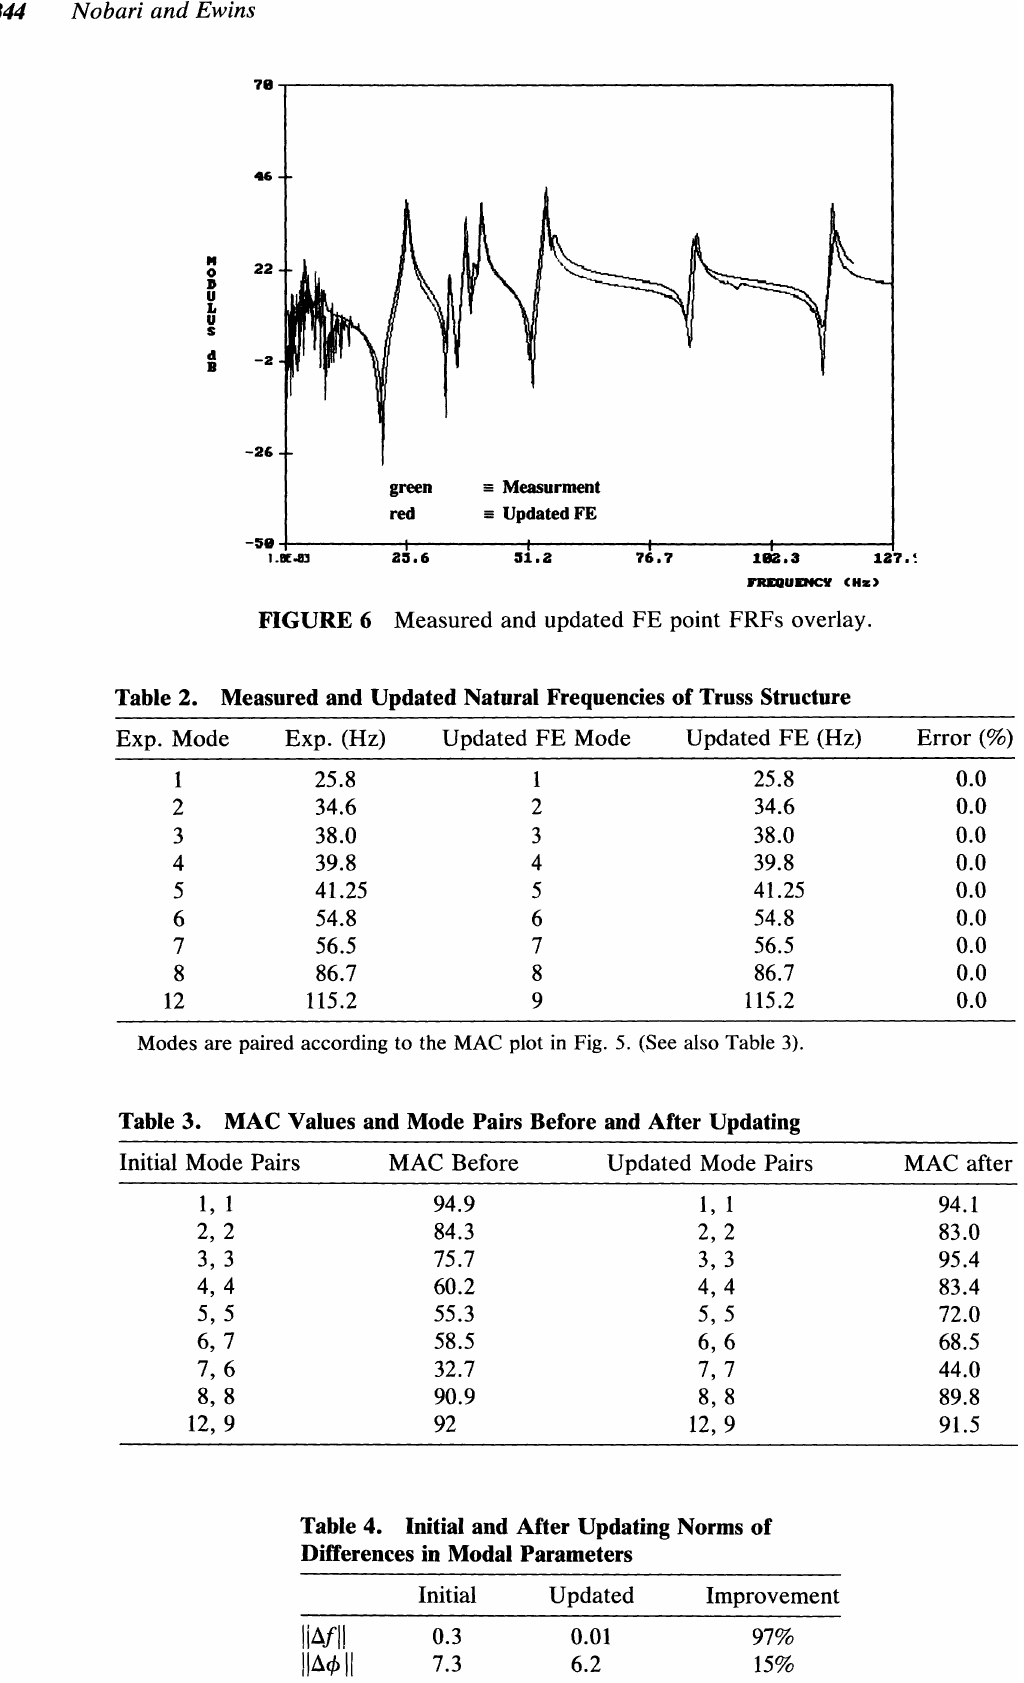
Table 4. Initial and Mter Updating Norms